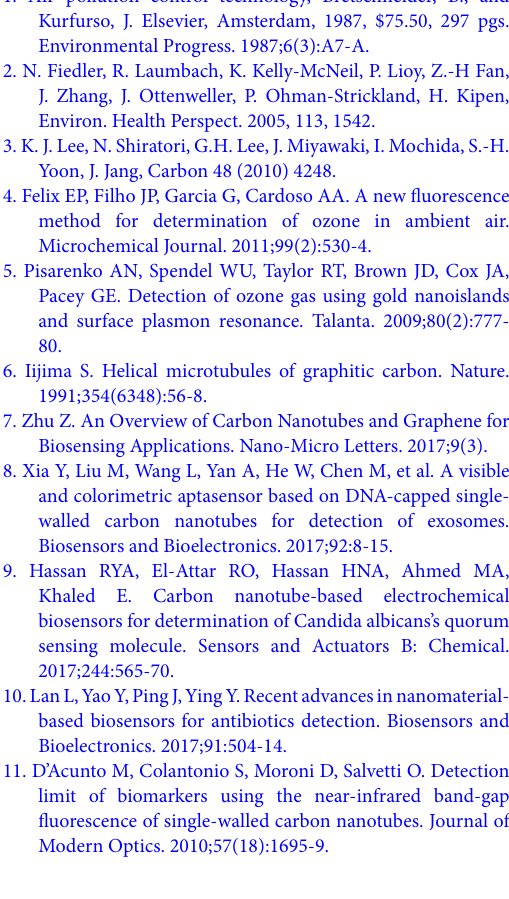
Fig. 9. Isosurface plots of charge density differences for O Figure 9. Isosurface plots of charge density differences for O 3 molecule adsorbed on the considered nanotubes.